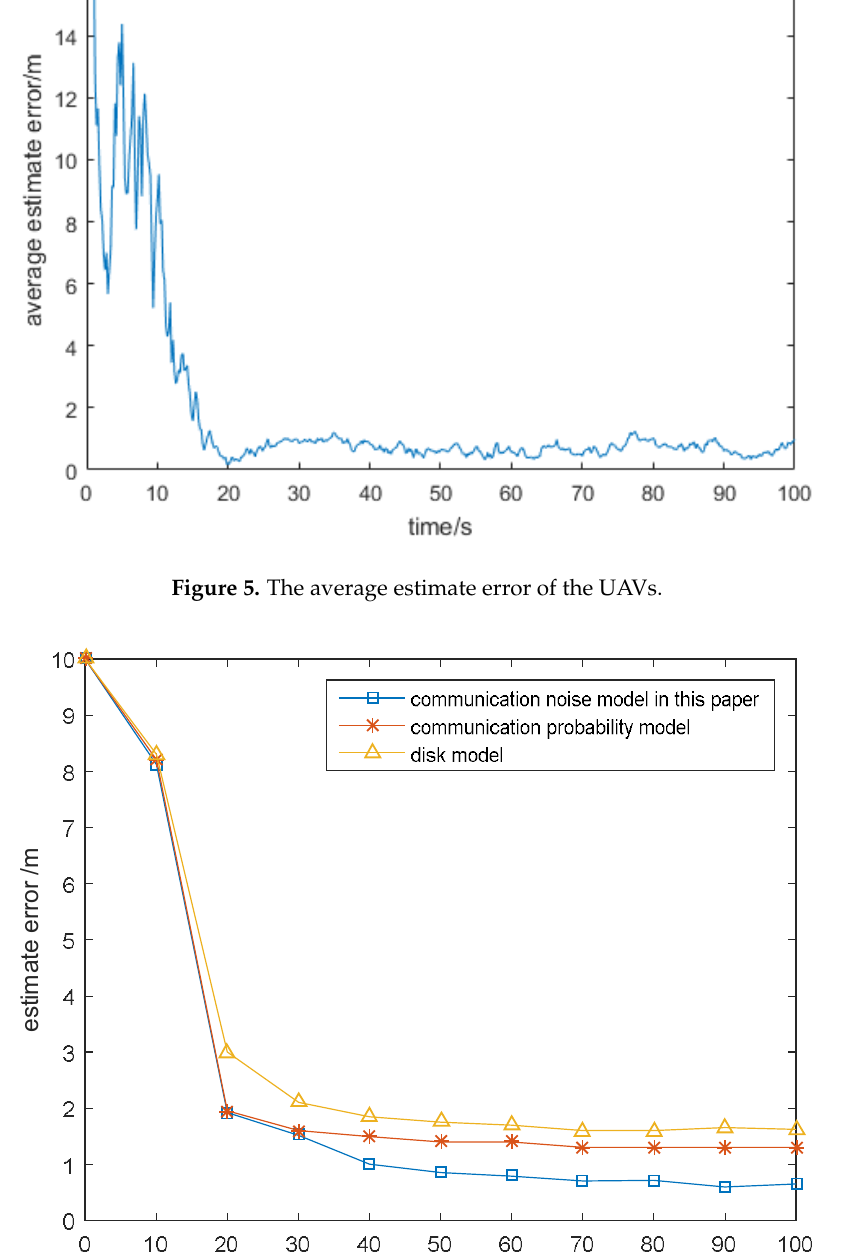
Figure 6. The average estimate error compared with other methods in the presence of distance- dependent path loss.